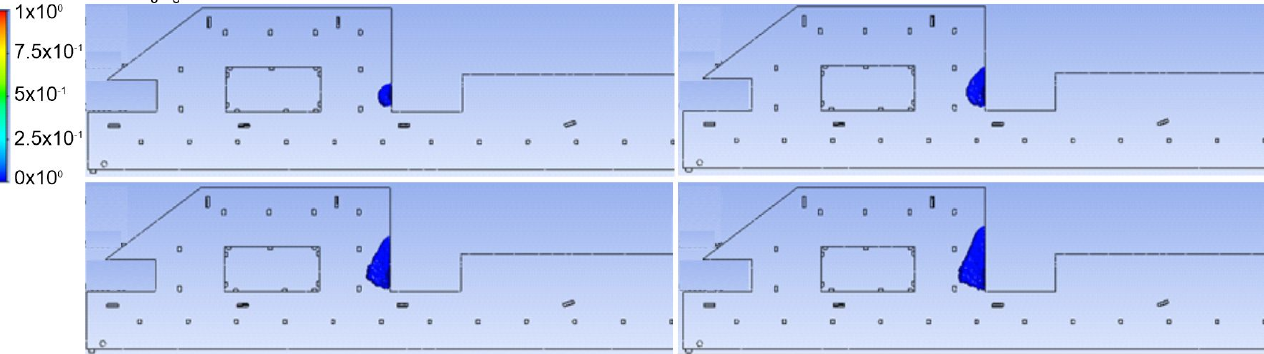
Figure 14. Lower explosive limit of LPG distribution in an underground garage after gas dispersion for B source for different time steps of 2.5 s, 5 s, 7.5 s and 10 s. For additional times, differences in gas dispersion were observed. For A source, a wider area occupied by gas compared to B source was observed. For A leakage source, the LEL area initially took up approximately 4.6% of the garage zone (time step equal to 15 s). Next, the LEL area decreased to 5.5%, 5.1% and 3.3% for 35 s, 55 s and 70 s, respectively. For B source of LPG leakage, the initial area was not similar, and its amount was 4.9%. However, 5.5% and 4.4% for 35 s, 55 s and 70 s, respectively. After 70 s for A source, most of the